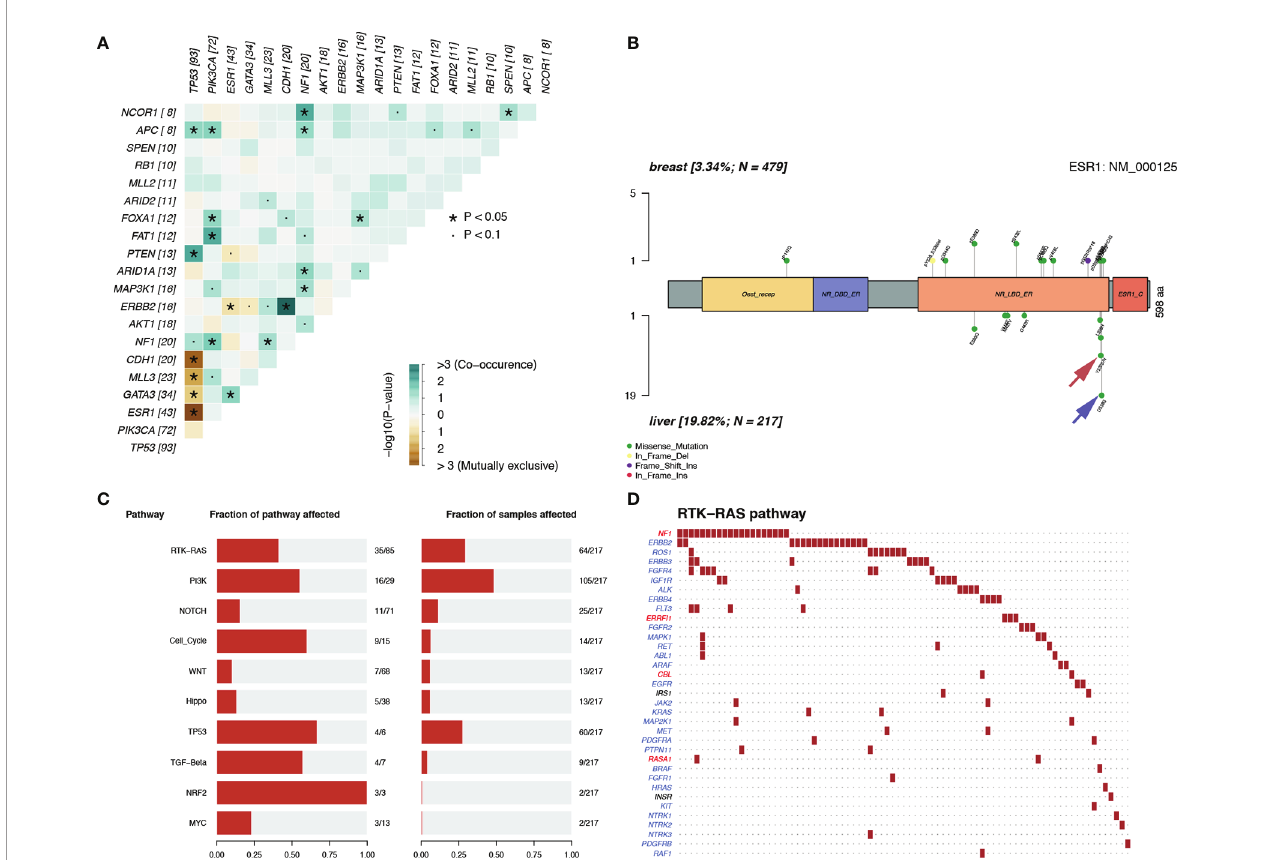
FIGURE 6 | Mutation patterns in patients with LM. (A) Mutually exclusive or co-occurring set of genes. (B) Lolliplot of ESR1 mutation rate in the patients with pBC and LM. (C, D) Enrichment of known Oncogenic Signaling Pathways (Tumor suppressor genes are in red, and oncogenes are in blue